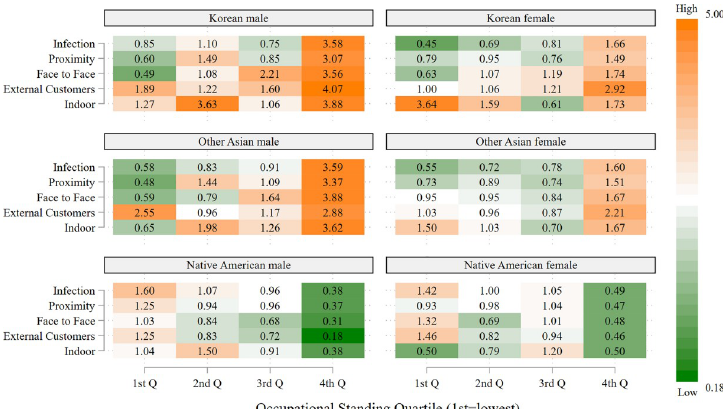
Fig 4. Representation of frontline workers in high-risk occupations relative to representation as frontline workers by occupational standing: Korean, other Asian, and native American workers, by sex. Data are from the 2018 American Community Survey (ACS). Occupations are considered to be high-risk if the average value for the risk factor in the O � NET data falls in the highest quartile of the occupations in the analysis. Occupational standing (OS) is defined as the percentage of ACS respondents reporting this occupation who completed at least one year of college education. The 1 st OS quartile is the lowest and the 4 th OS quartile the highest.